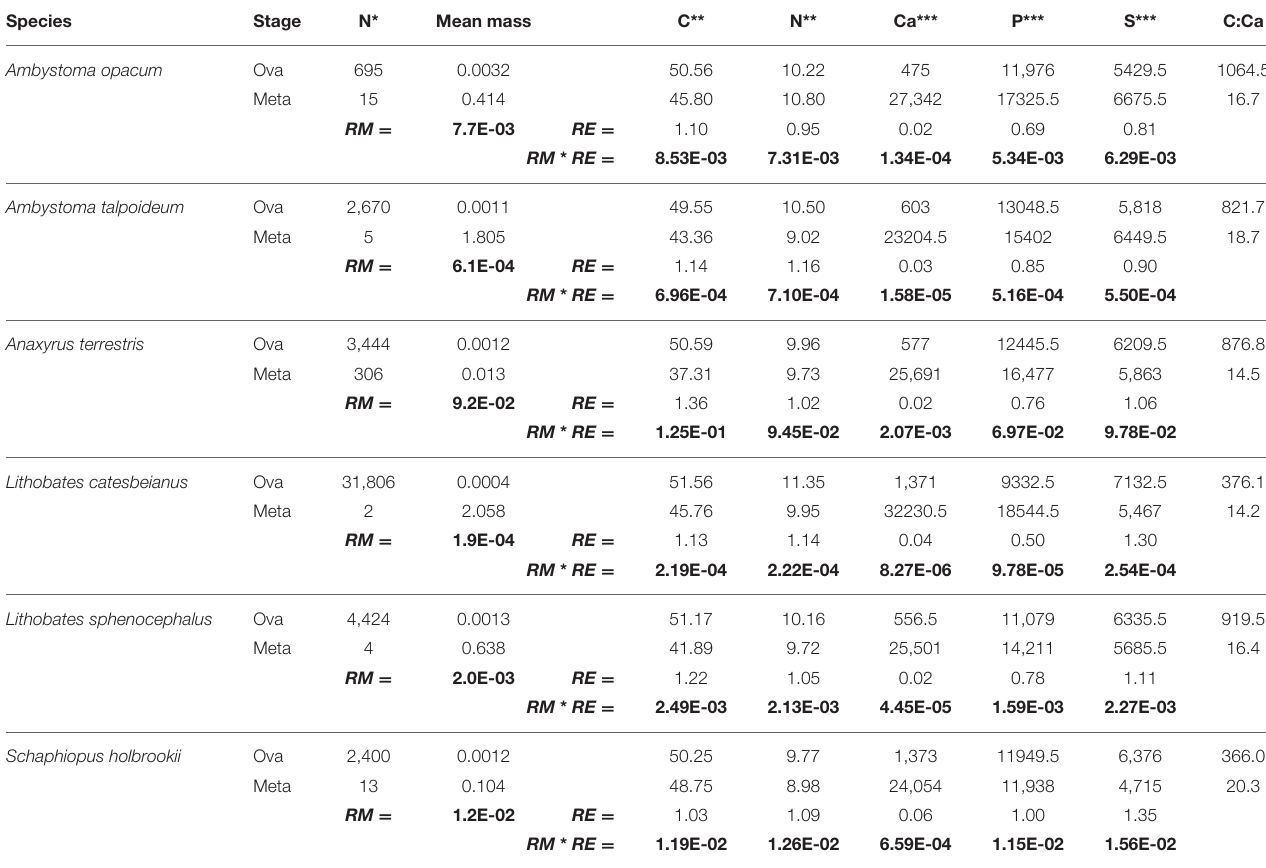
TABLE 1 | Summary of ova and metamorph size and elemental composition for 6 amphibian species with larval survivorship values (boldfaced) where biomass flux ( RM ) and element-specific flux ( RM * RE ) are balanced between terrestrial and aquatic systems.